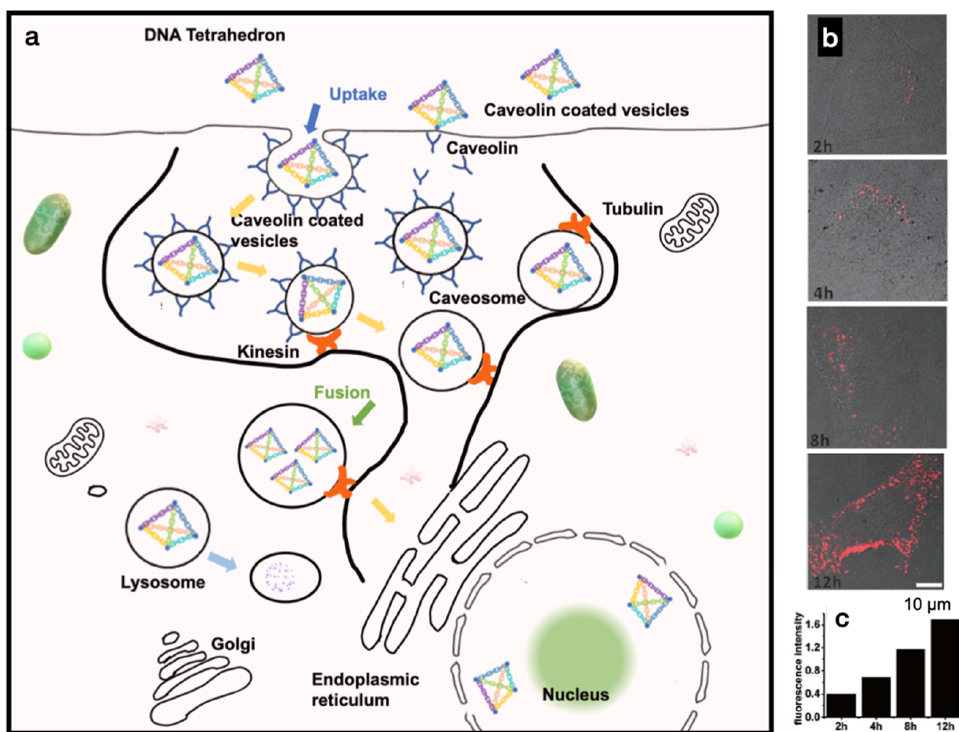
Figure 2. ( a ) Schematics of the cellular uptake, transport, and fate of TDNs. ( b ) Internalization of TDNs by HeLa cells treated with Cy3-conjugated TDNs for 2, 4, 8, and 12 h. ( c ) Flow cytometry analysis of cellular uptake of Cy3-TDNs. Adapted with permission from [24] Copyright © 2022, WILEY-VCH Verlag GmbH & Co. KGA, Weinheim.